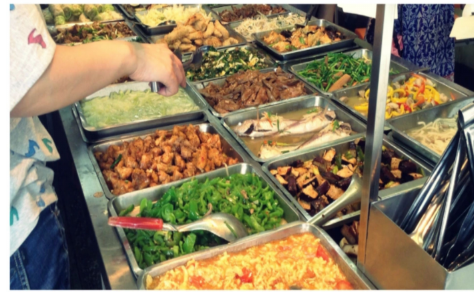
Figure 1. Foods in a Bento buffet cafeteria.